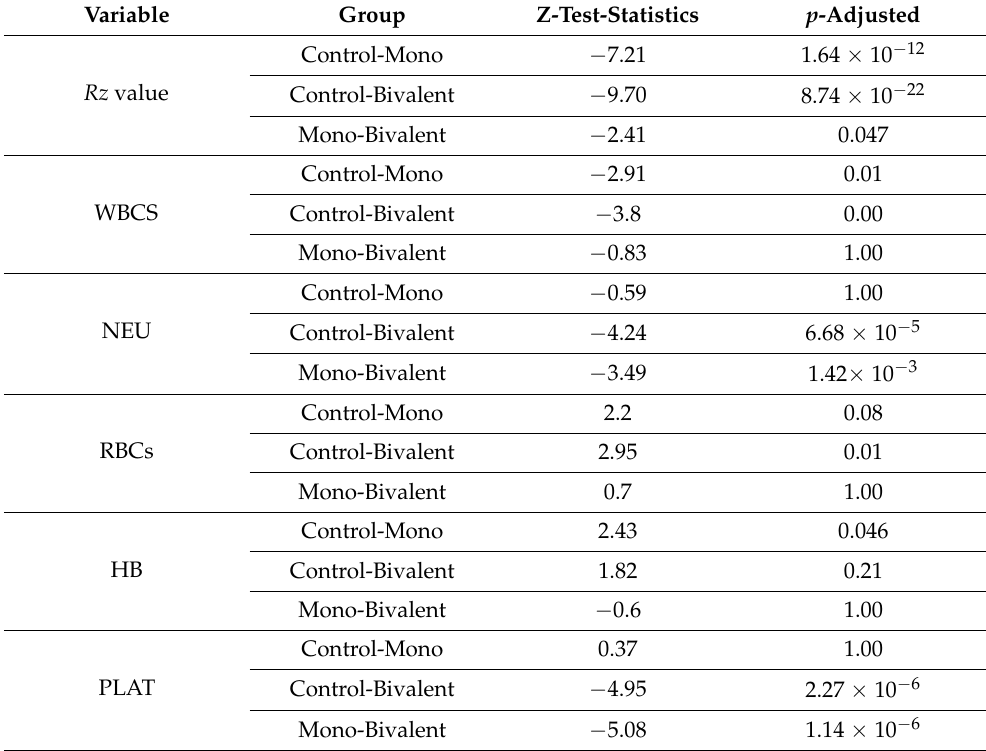
Table 2. Dunn post hoc test of significantly different